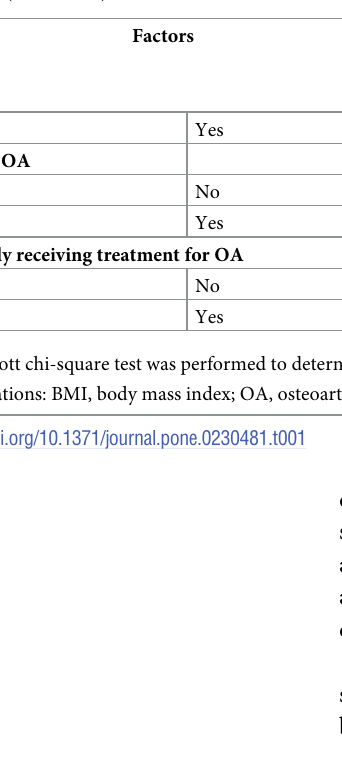
Table 2. KL grade and sleep duration, by types of joint.